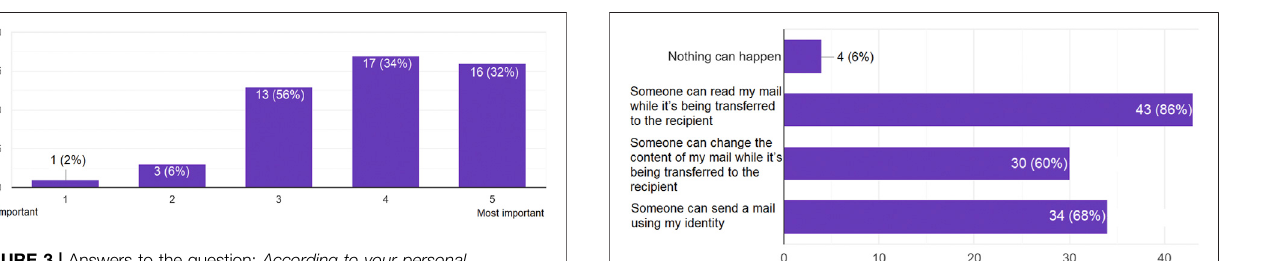
FIGURE 3 | Answers to the question: According to your personal impression, how would you scale the importance of e-mail encryption? .